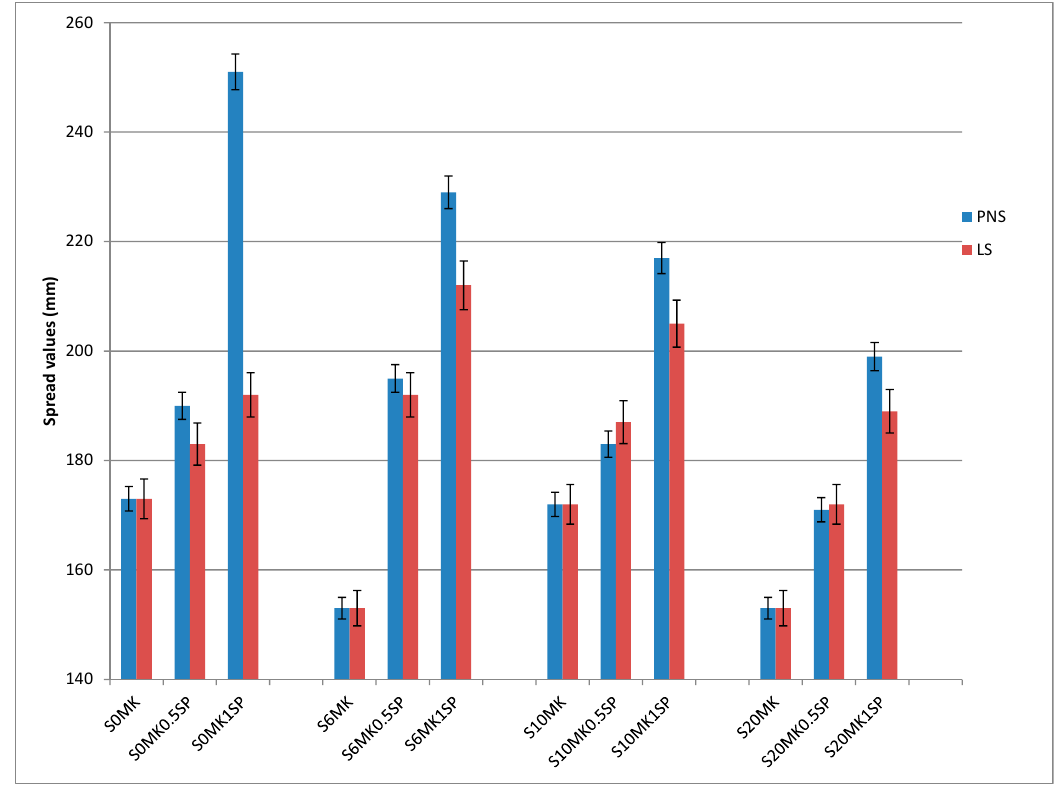
Figure 1. Fluidity values (slump measured in the flow table test) of the different grouts.